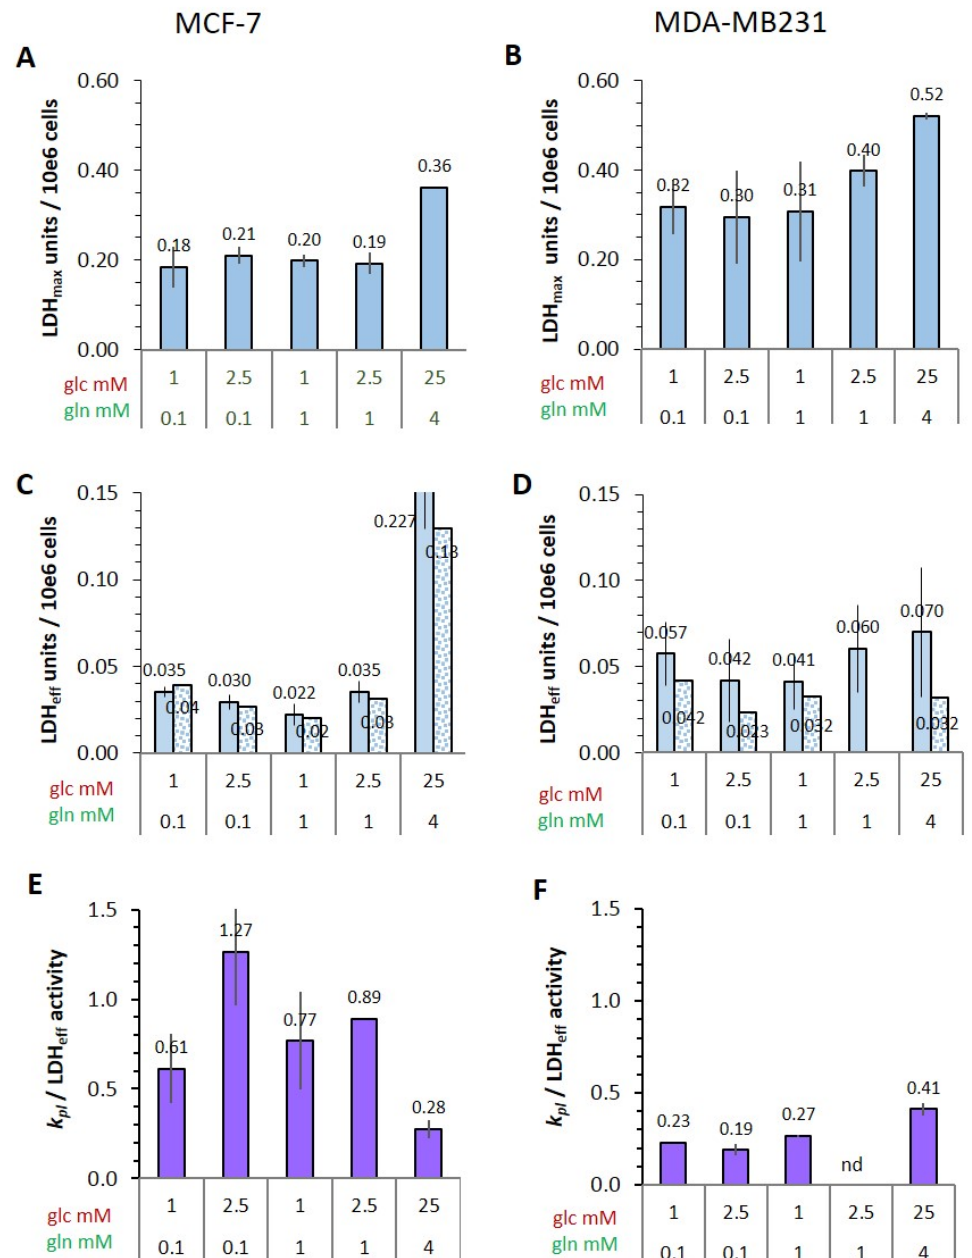
Figure 6. Differences in potential and effective cellular LDH activities and their relation to the conversion rate of hyperpolarized [1- 13 C]pyruvate-to-[1- 13 C]lactate. ( A , B ) Potential LDH (LDH max ) was determined in lysates from monolayer cultures using the LDH-based assay with saturating substrate concentrations. ( C , D ) Effective LDH activities (LDH eff ) were calculated with values of the intracellular metabolite and coenzyme concentrations (Table S1; Figure 5) and the maximal LDH max activity (Figure 6A,B; Table S2). Values of the speckled bars are from cell lysates after 13 C-MRS-measurements. The Michaelis–Menten equation was applied with the assumption that NADH is already bound (K M -values in Figure 3). The speckled bars represent values from trypsinized cells after MRS. ( E , F ) Ratio of k pl to LDH eff activity ( k pl -values from Figure 2G,H). LDH max values were obtained from three independent experiments using lysates from monolayer cultures and from two experiments following 13 C-MRS measurements of cell suspensions (Figure 2; Table S2).